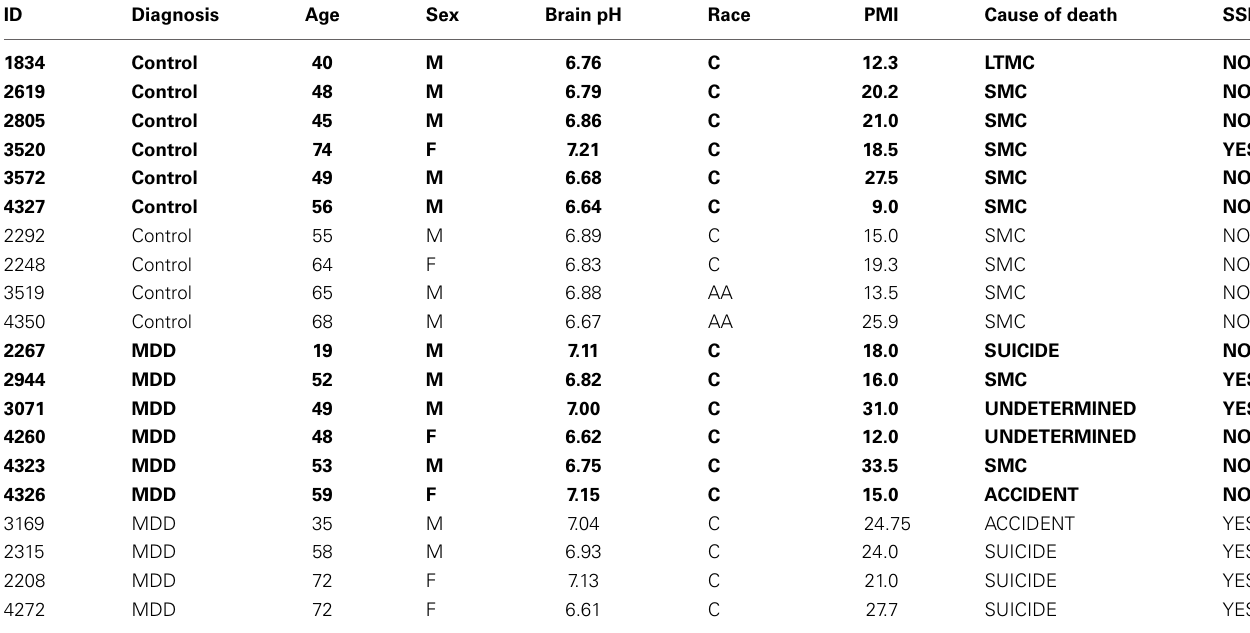
Table 1 | Demographics for choroid plexus samples included in the mircorarray and qRT-PCR